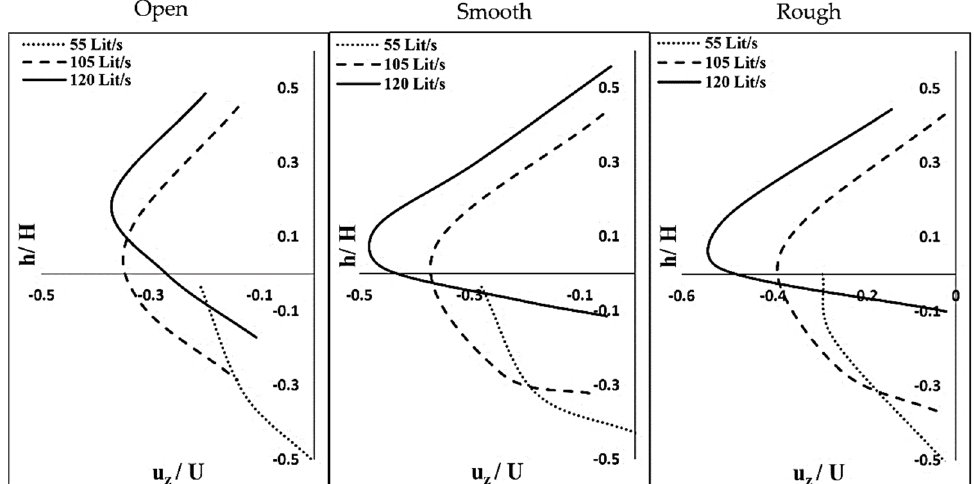
Figure 14. Vertical velocity profile (u z ) inside and outside the scour holes under conditions of different flow rates and surface cover (the dike orientation angle is 90°). ADV measurements subject to +/- 0.25 cm/s error.